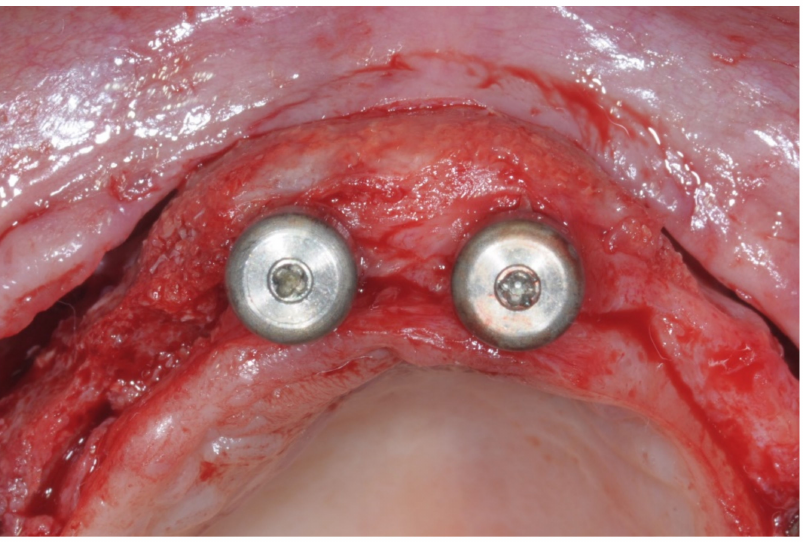
Figure 14. Occlusal view after 9 months of healing showing the newly regenerated